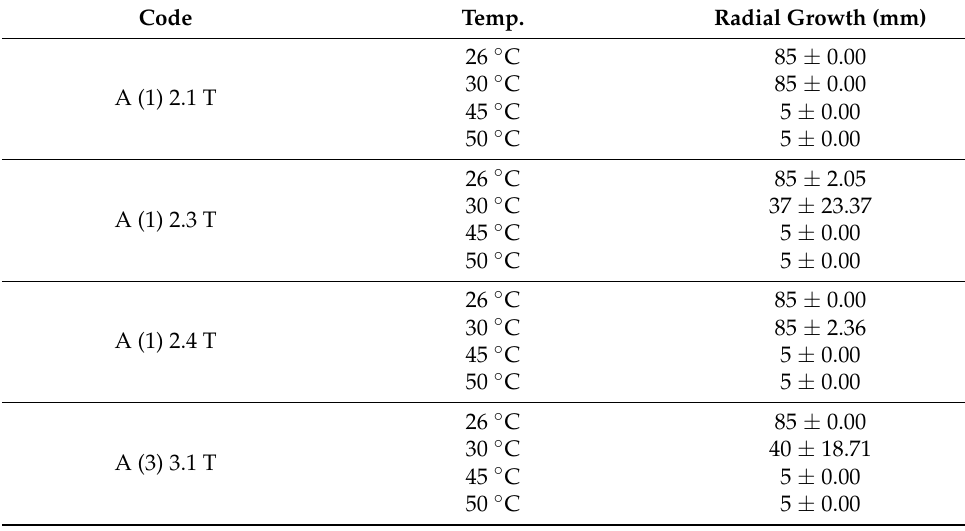
Figure 2. Inhibitory effect of the culture filtrate of Trichoderma isolates. The data on the effect of different temperatures on the radial growth of Trichoderma isolates shows that, in general, the optimum temperature for their maximum growth ranges between 26 °C and 30 °C. At temperatures of 45 °C and 50 °C, the rate of radial growth was weak. The lowest growth of Trichoderma was at temperatures of 50 and 45, with a mean of 5 mm for all samples (Table 4). Table 4. Effect of different temperature on the growth of Trichoderma isolates. Code Temp. Radial Growth